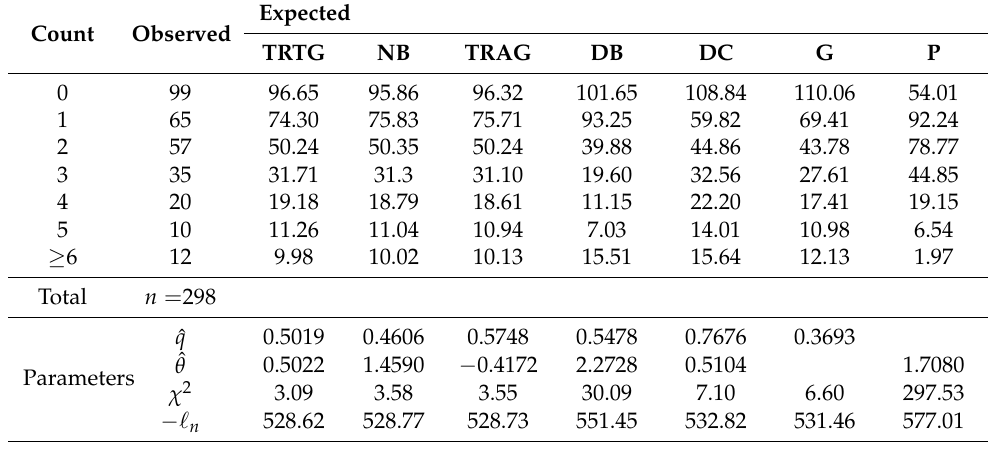
Table 5. Results of observed and expected frequencies, χ 2 and − (cid:96) n , respectively, for first data.